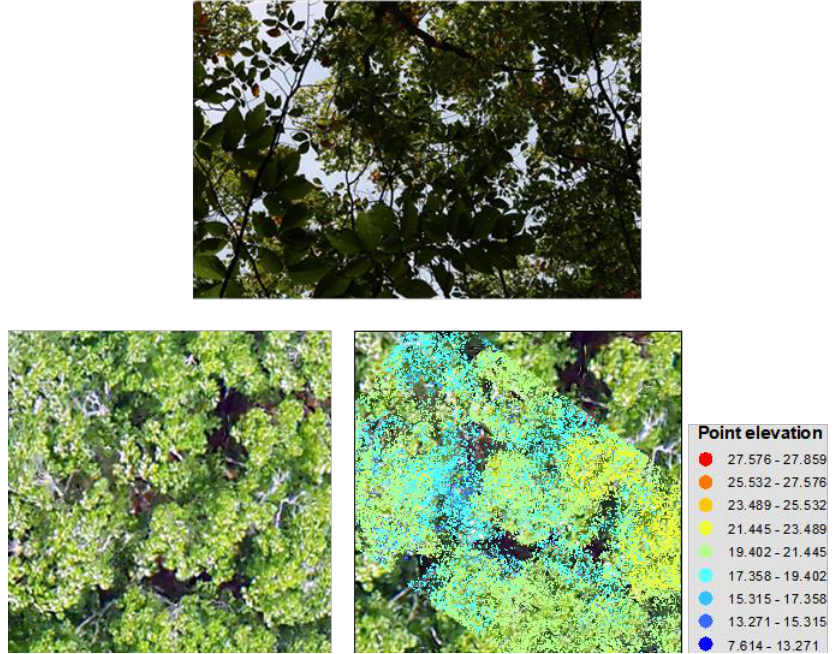
Figure 3. Comparison between digital cover photo (DCP) ( top ), the 2.5 cm orthomosaic ( bottom- left ) and the photogrammetric point cloud ( bottom-right ) for approximately the same